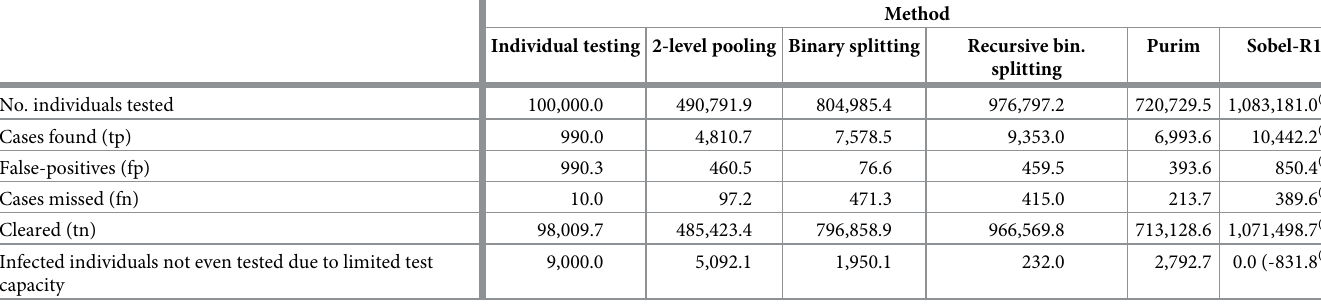
Table 3. Effectiveness of conducting 100,000 tests on a population of 1 million; full statistics over 10 simulations